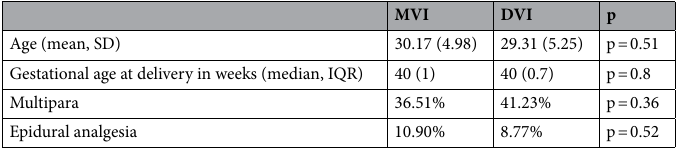
Table 1. Demographic characteristic of study groups. SD standard deviation, IQR interquartile